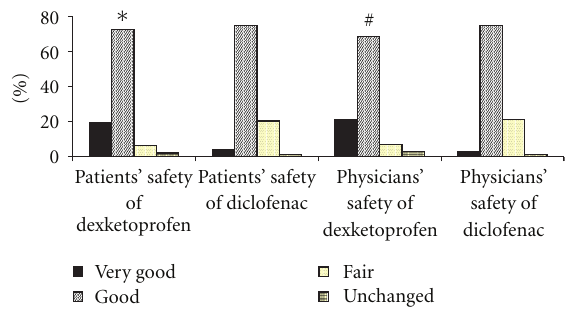
Figure 3: Patients’ and physicians’ global assessment of safty ∗ P = . 0097 and # P = . 02 with Fisher’s exact test for proportions between (very good + good) versus (fair +